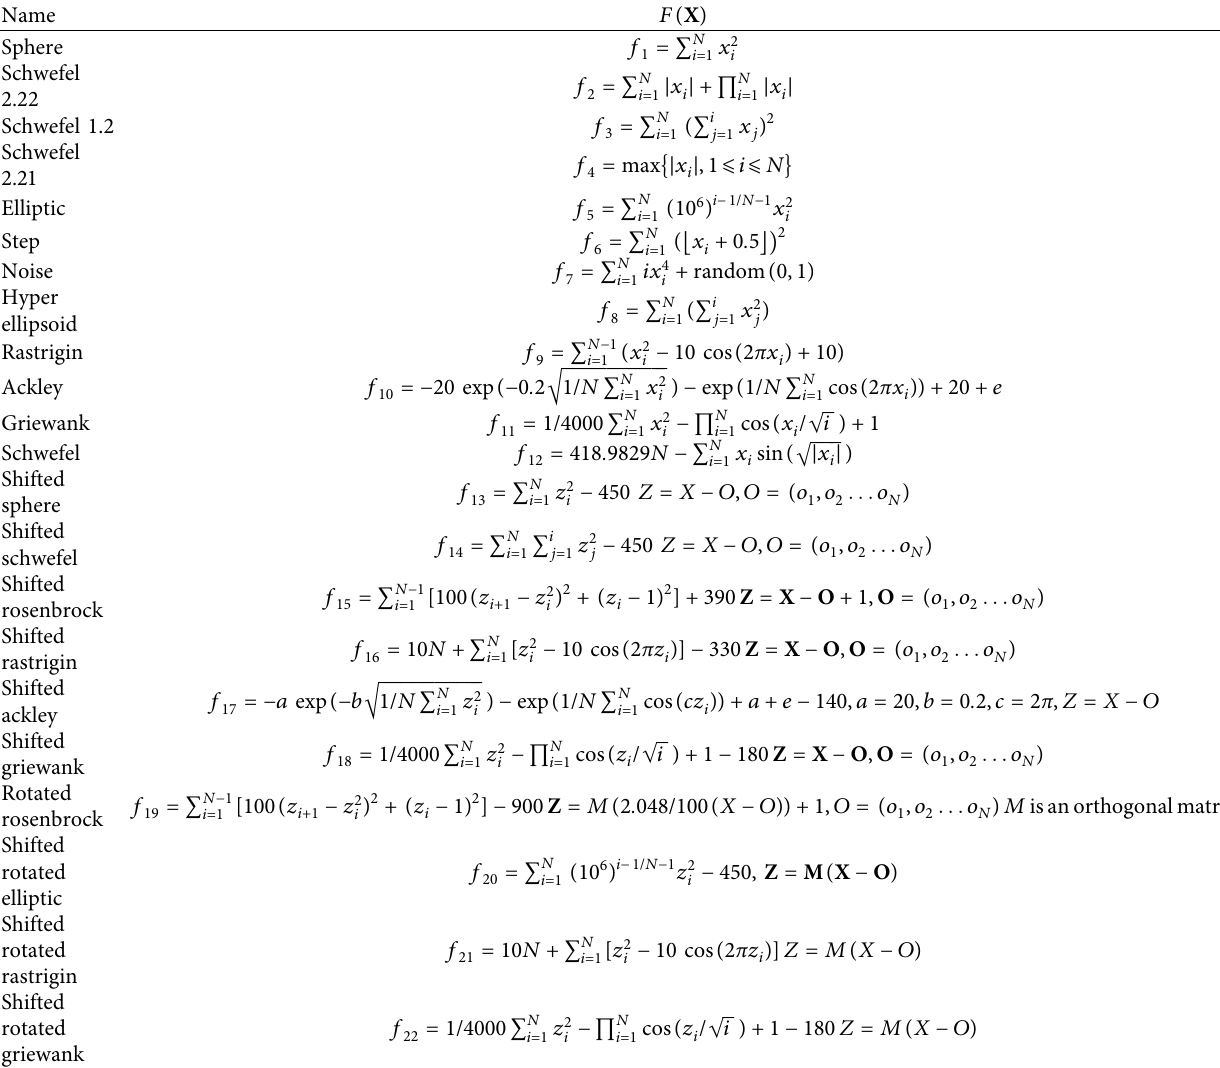
Table 1: Te benchmark functions used in the